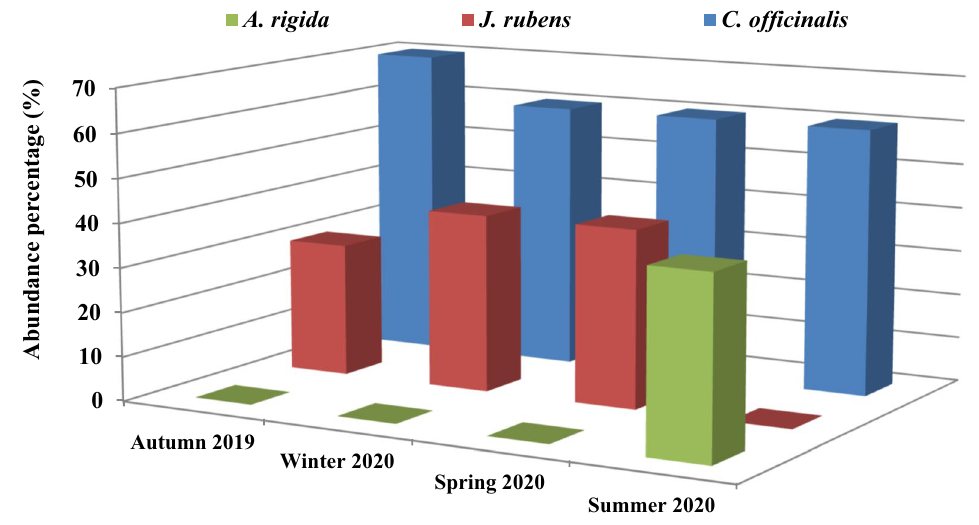
Fig. 1 Seasonal abundance distribution (% of total species individuals) of the collected calcified species